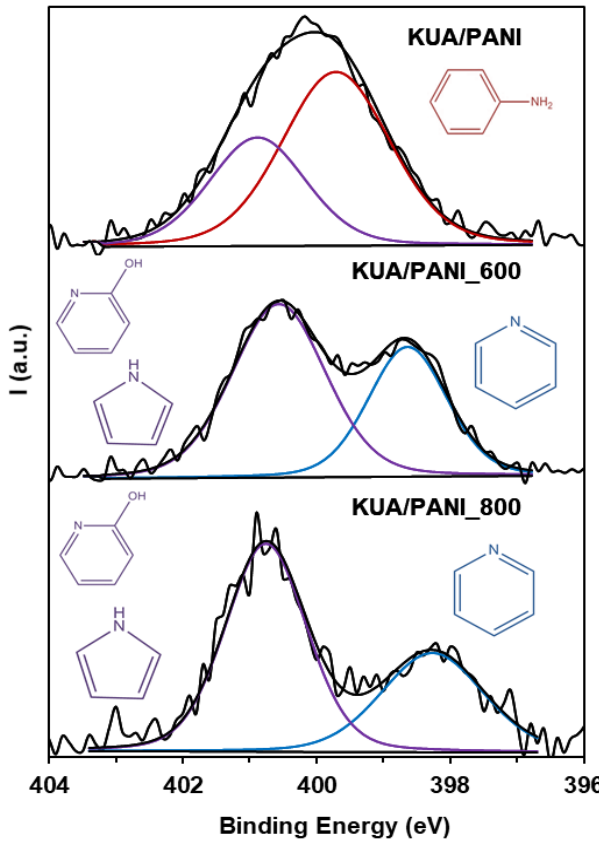
Figure 2. N1s XPS spectra deconvoluted for the KUA / PANI composite and the N-doped activated carbons.